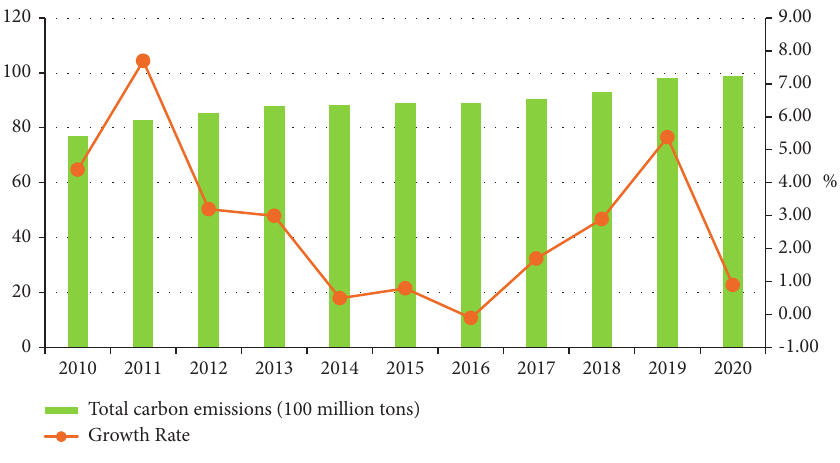
Figure 1: Total Carbon Emissions and Growth Rate in China, 2010–2020.